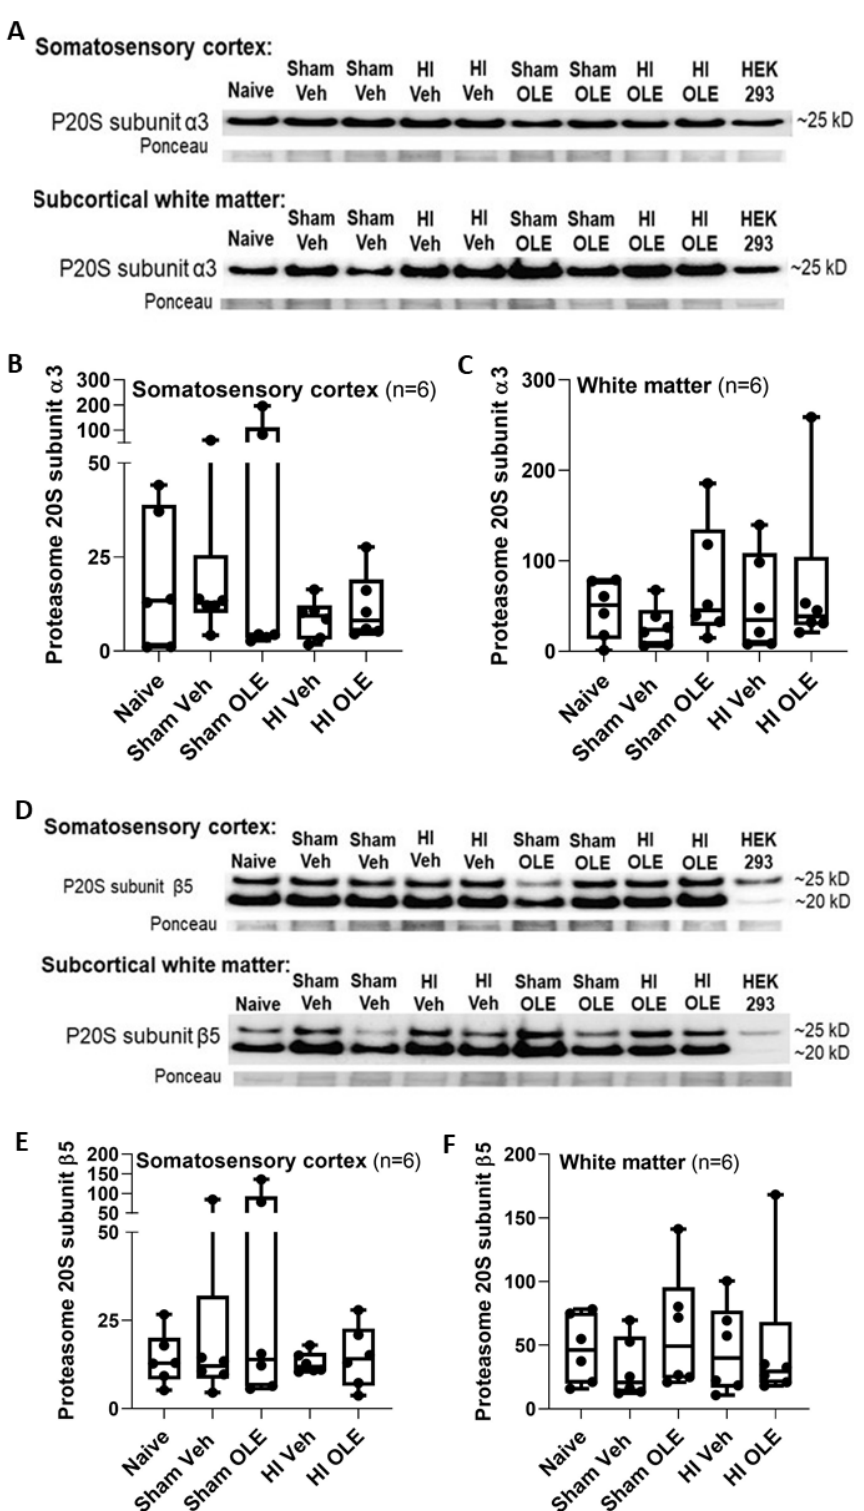
Figure 6. Western blotting was used to measure proteasome 20S (P20S) subunit immunoreactivity levels in piglets that received hypoxia-ischemia (HI) or sham procedure with oleuropein (OLE) or vehicle (Veh). Naïve, unanesthetized piglets were an additional control group. ( A – C ) P20S subunit α 3 levels did not differ in the cortex ( p = 0.806) or white matter ( p = 0.594). ( D – F ) P20S subunit β 5 levels also were not different in the cortex ( p = 0.986) or white matter ( p = 0.564). Ponceau S-stained membranes show protein loading ( A , D ). The box plot whiskers show the 5th and 95th